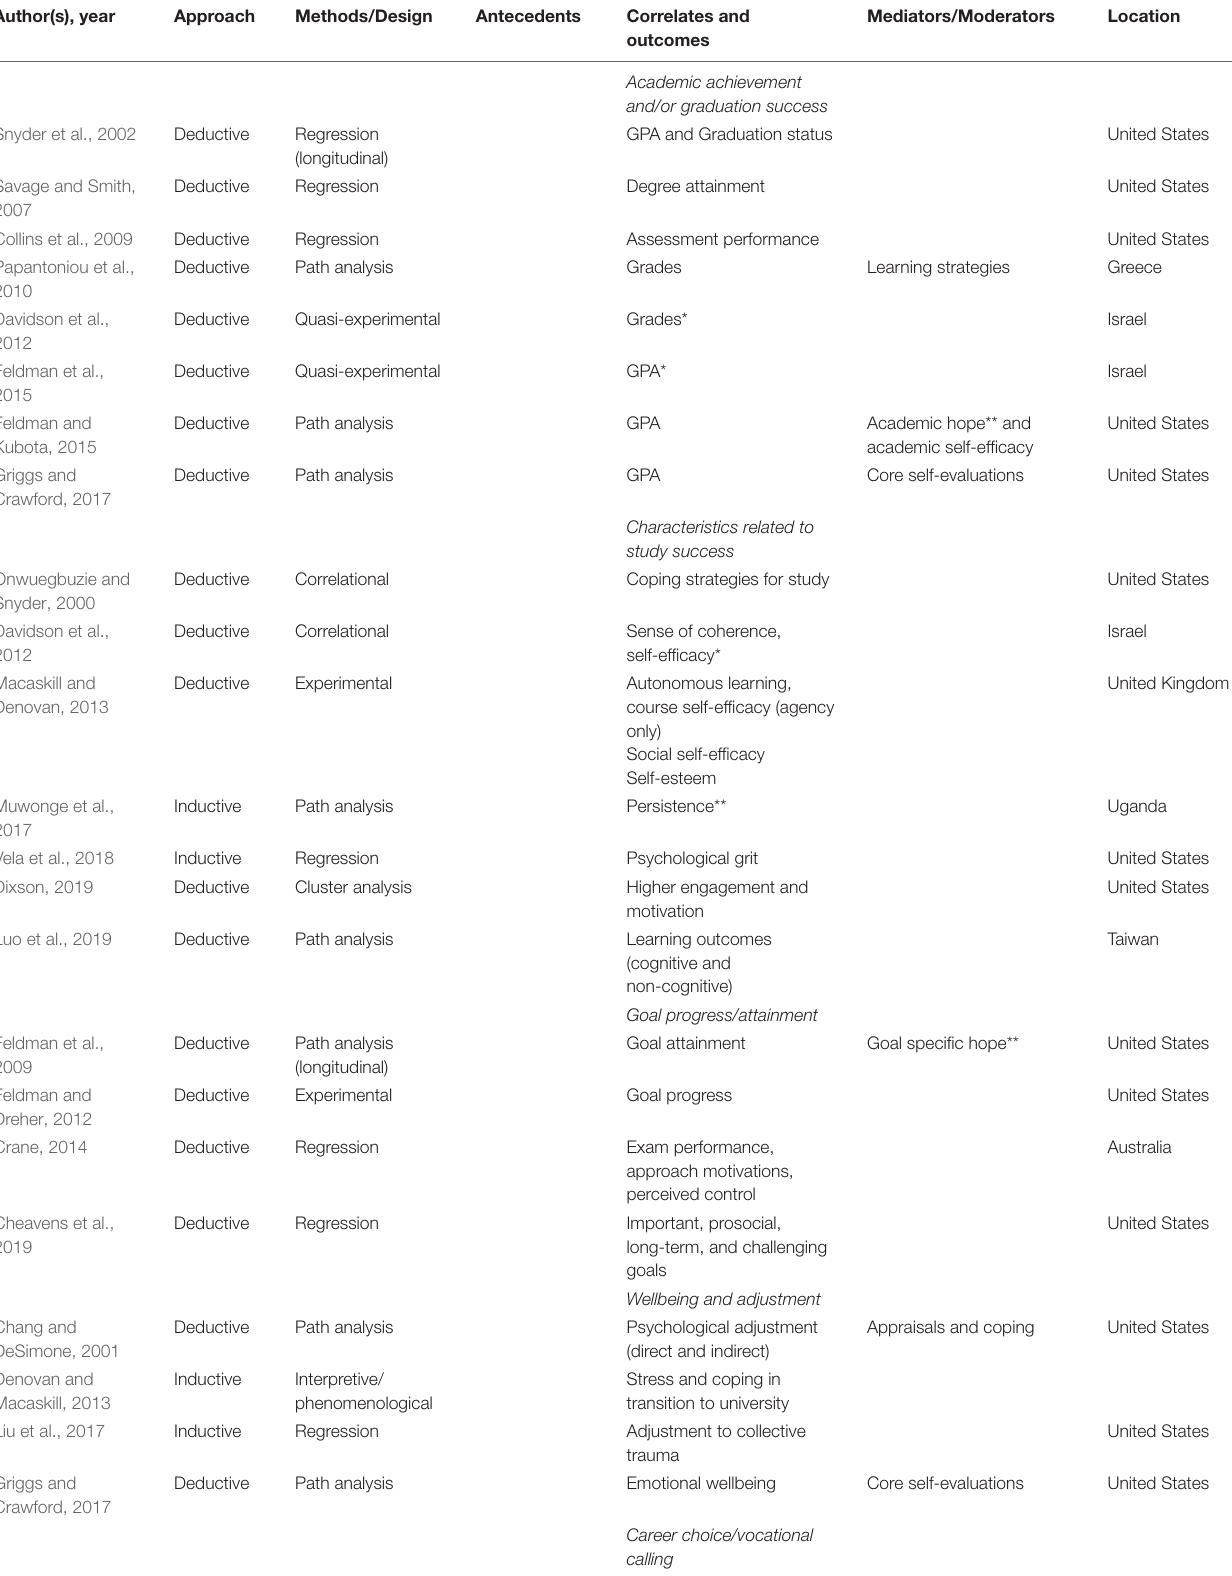
TABLE 1 | Summation of research testing hope theory propositions, correlates, and outcomes in young people in higher